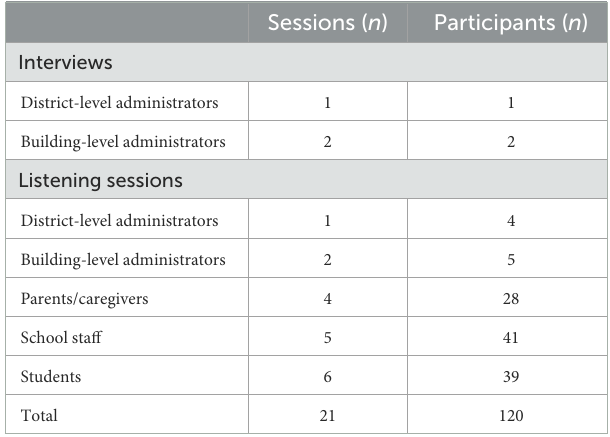
TABLE 2 Listening sessions/interviews and